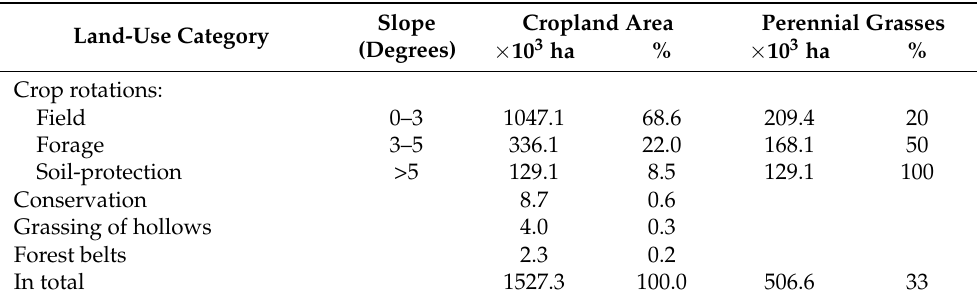
Table 1. Modeled structure of cropland in Belgorod Oblast, according to the project of river-basin nature management.